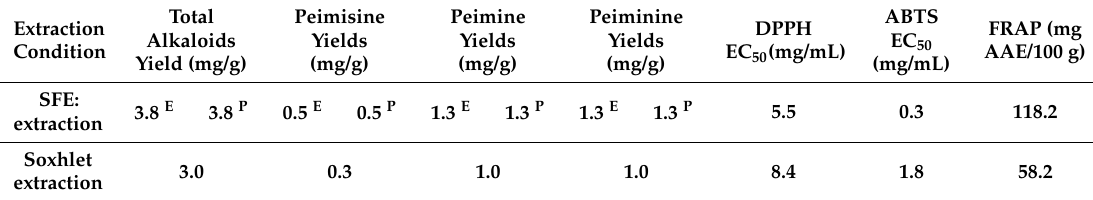
Table 3. Extraction yields of total alkaloids, peimisine, peimine and peiminine and antioxidant capacity of total extract from the bulb of F. thunbergii Miq. (mean ˘ SD, n =